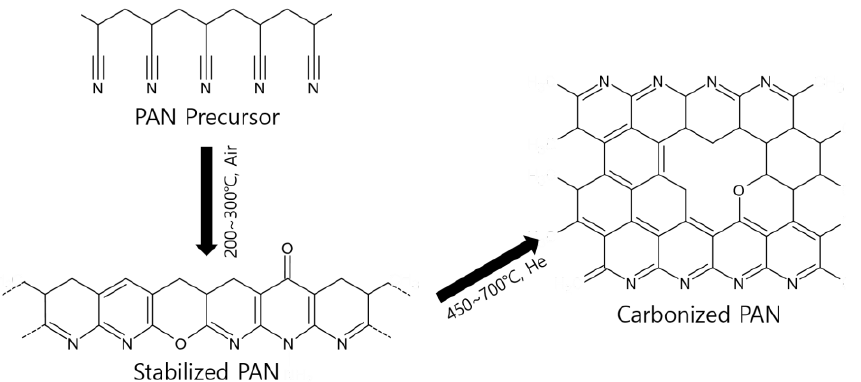
Figure 1. Illustration of the PAN stabilization and carbonization reaction.